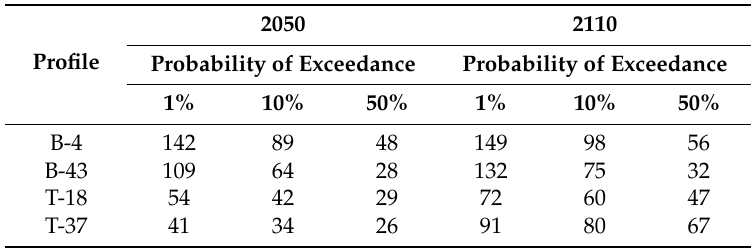
Table 2. Coastal recession magnitudes (m) associated with different exceedance probabilities in 2050 and 2110 for selected profiles.